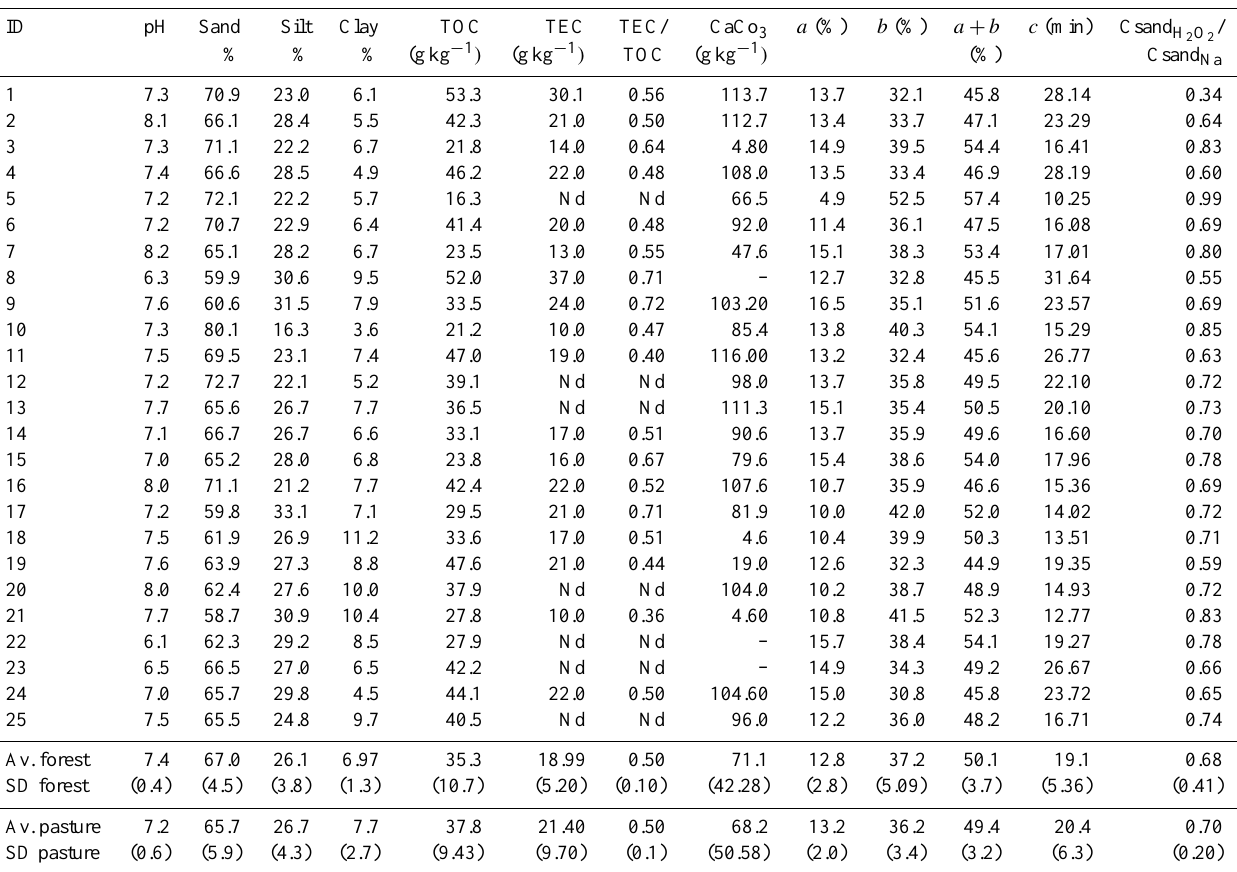
Table 1. Selected soil properties at sampling